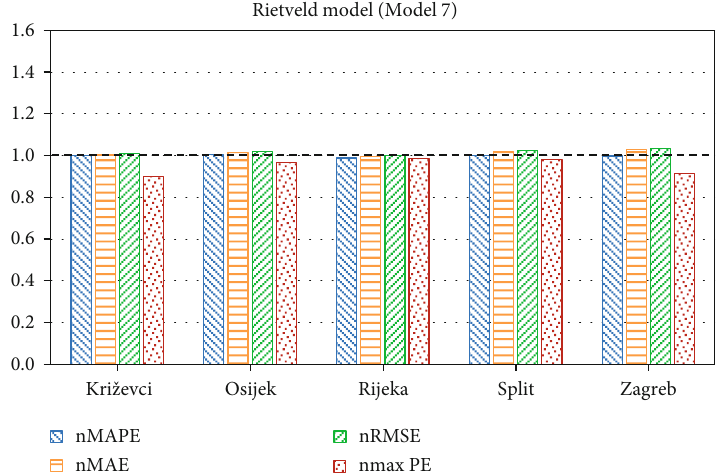
Figure 7: Comparison of statistical parameters (MAPE, MAE, RMSE, and max PE) for the Rietveld model based on the data from fi ve stations (Kri ž evci, Osijek, Rijeka, Split, and Zagreb). All parameters are shown as relative values adjusted to the original model.